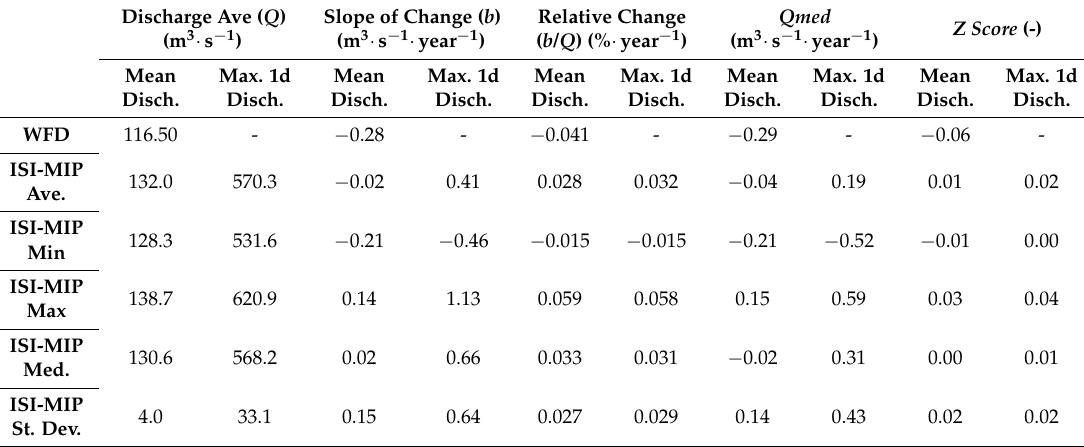
Table 5. Global-averaged results of annual-mean and annual-maximum 1-day streamflow trend analysis—WBM streamflow simulations based on the WFD observation-based inputs as well as from the ISI-MIP (WBM model driven by GCM climate forcing), for 1971–2001. The 5 ISI-MIP models give 5 global averages, of which the minimum, maximum, median, mean, and standard deviation are presented. The average discharge magnitude (Q) values are per grid cell. Ave. = Average, Min. = Minimum, Max. = Maximum, Med. = Median, St. Dev. = Standard